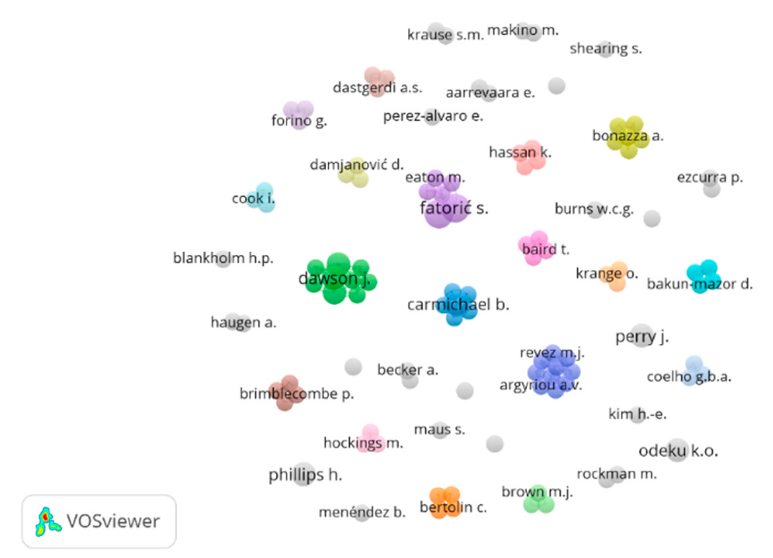
Figure 5. Co-author networks. Source: own elaboration.